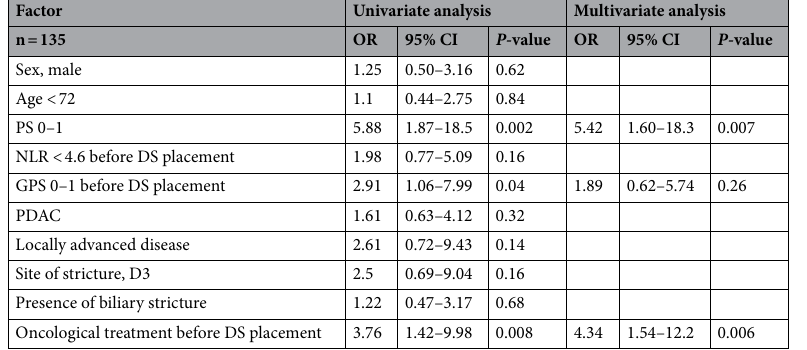
Table 5. Predictive factors for achievement of GOOSS 3 after DS placement. CI confidence interval, DS duodenal stent, GOOSS Gastric Outlet Obstruction Scoring System, GPS Glasgow Prognostic Score, HR hazard ratio, NLR neutrophil-to-lymphocyte ratio, PDAC pancreatic ductal adenocarcinoma, PS performance